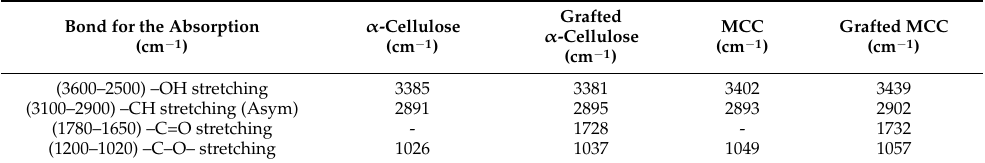
Table 2. Prominent peaks of α -cellulose, grafted α -cellulose, MCC, and grafted MCC based on their FTIR spectra and possible bond for the absorption.